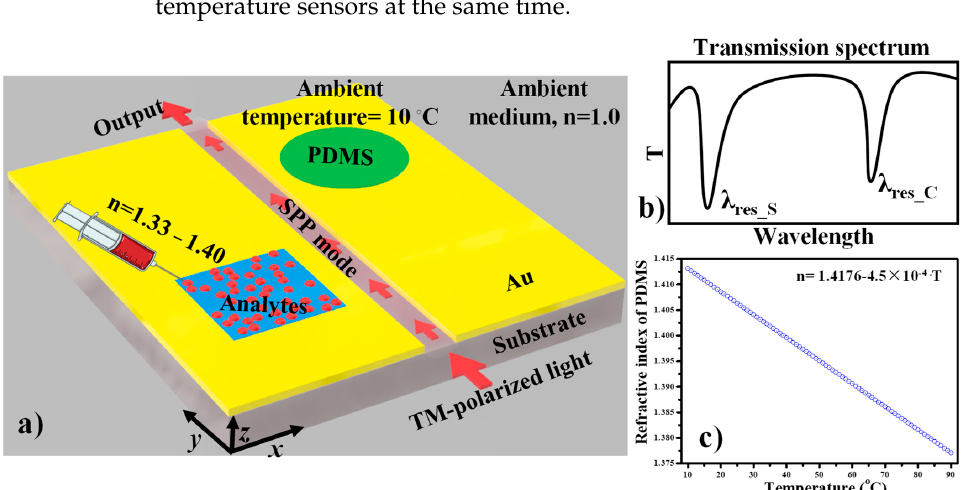
Figure 5. ( a ) Schematic representation (3D view) of a plasmonic sensor for simultaneous sensing of biological analytes and temperature, ( b ) The intended transmission spectrum of the proposed device, ( c ) Variation in the refractive index of the PDMS material versus the ambient temperature.